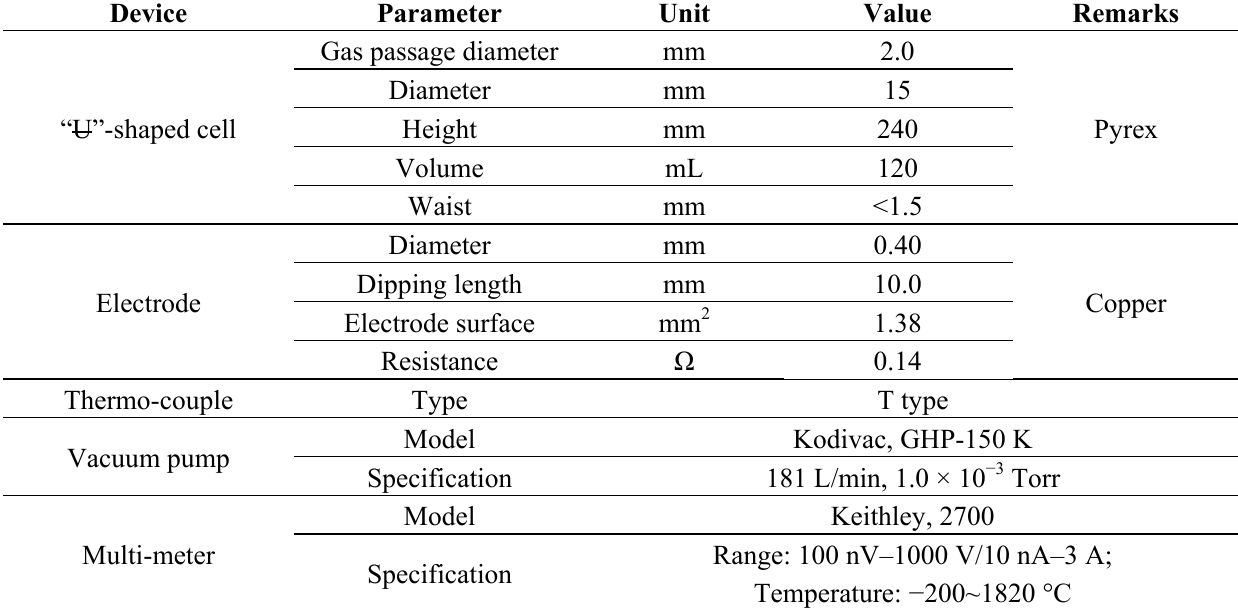
Table 1. The related specifications of Figures 1 and